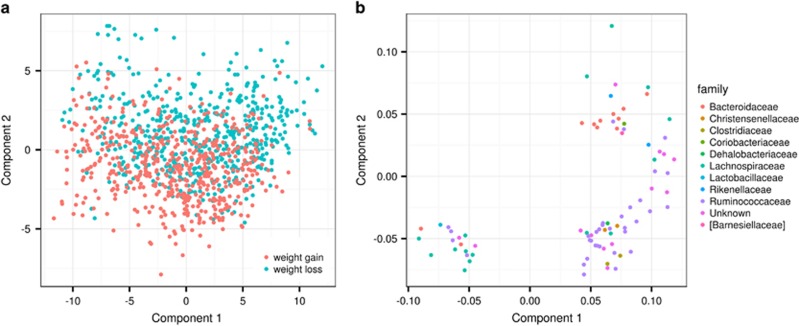
(a) Partial least square discriminant analysis score plot based on the relative abundances of OTU in the gut microbiota and their association with weight gain and weight loss. (b) Partial least square discriminant analysis loading plot based on the relative abundances of OTU in the gut microbiota and their association with weight gain and weight loss. The OTU with variable influence on projection (VIP) >1 are shown and coloured according to their corresponding family.